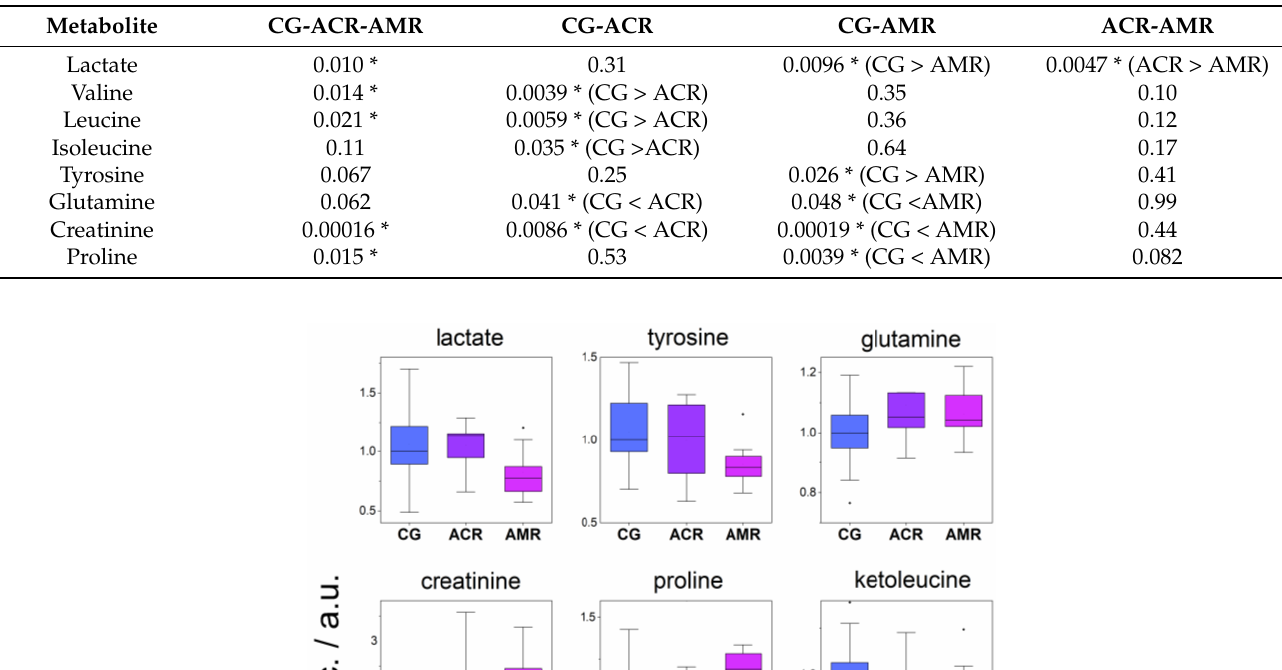
Table 5. Evaluation of changes of relative levels of plasma metabolites in patients without signs of rejection (CG), with acute cellular rejection (ACR), and acute antibody-mediated rejection (AMR), p -values obtained by Kruskal–Wallis test for multiple comparisons with post hoc Dun’s test for pairwise comparison. The direction of changes is indicated in parenthesis, * significant difference.